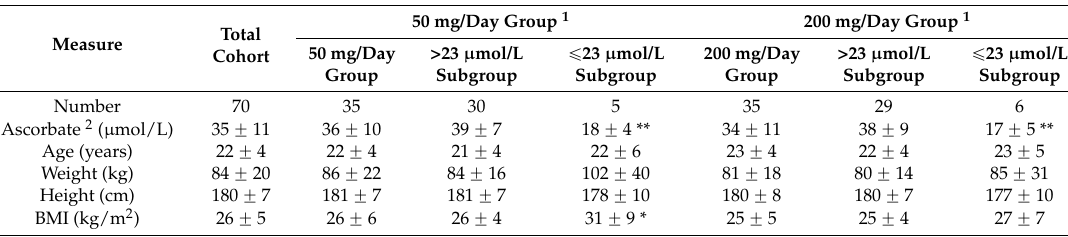
Table 1. Group characteristics at study entrance.